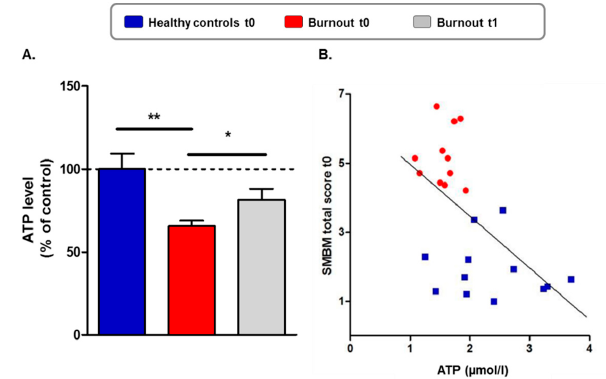
Figure 1. Reduced ATP levels in individuals with burnout and impact of physical activity. ( A ) ATP levels were normalized to the mean of the healthy control group at baseline (100%). ATP levels in the group of individuals with burnout at baseline (t0) were significantly lower compared to those of the healthy control group. At study end (t1), ATP levels significantly increased in individuals with burnout compared to baseline (t0). Student’s t -test * p < 0.05, ** p < 0.01. Values are represented by the mean ±SEM. ( B ) Correlation of absolute ATP levels (µmol/l per 2 × 105 cells) with total score of the Maslach Burnout Inventory (MBI) for the entire sample at baseline (t0). ATP levels decreased with increasing symptoms of emotional exhaustion. Pearson’s correlation coefficient − 0.62 p < 0.001